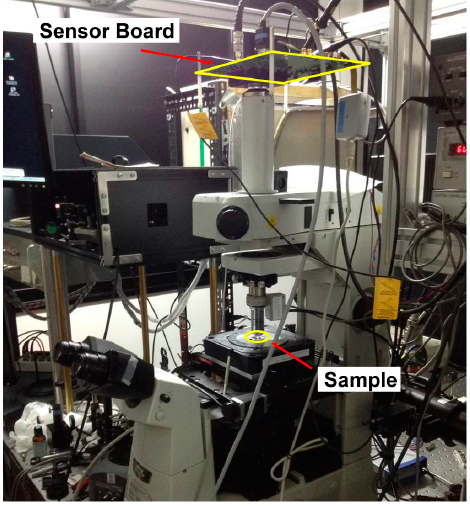
Figure 15. Photograph of the measurement setup for SRS.